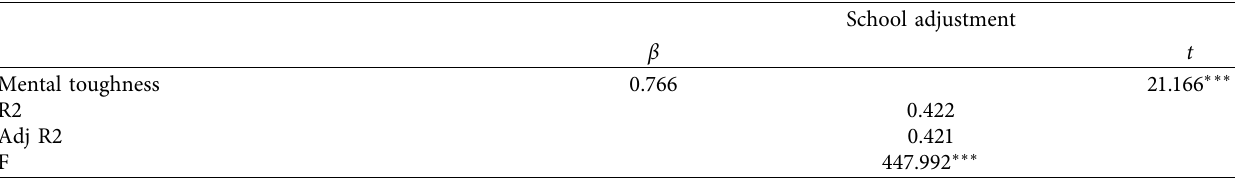
Table 7: Analysis table of psychological resilience and school adaptation hypothesis.